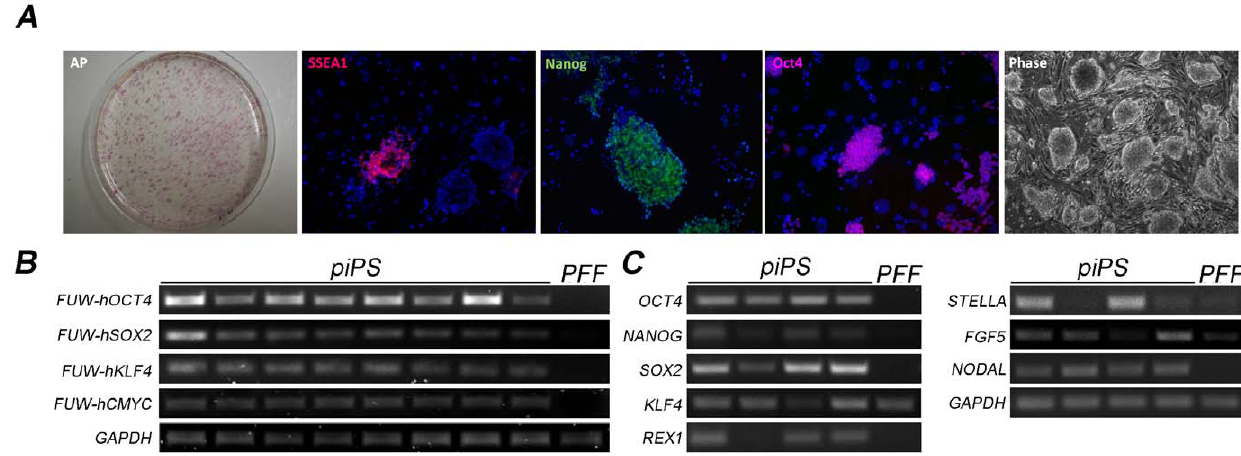
Figure 3. Characterization of piPS cells. A) Alkaline phosphatase, SSEA1, NANOG and OCT-4 staining in colonies of piPS cells. Phase contrast image shows the morphology of cells under low magnification. B) Expression of exogenous factors was determined by RT-PCR in 8 cell lines. PFF: porcine fetal fibroblasts used for generating the iPS cells. C) RT-PCR analysis of four iPS cell lines shows variables levels of gene expression of endogenous